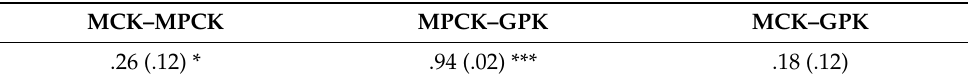
Table 3. Bifactor model: Latent partial correlations between the specific factors (standard errors in parentheses).